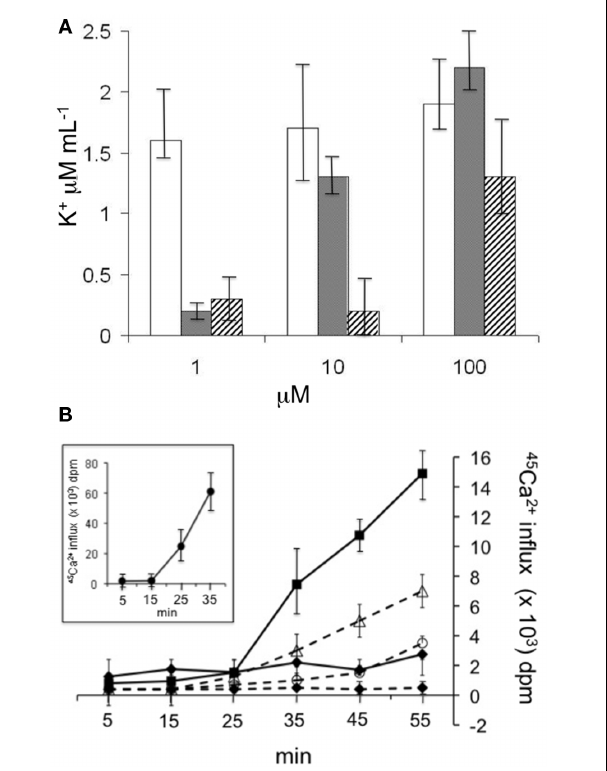
FIGURE 2 | Influence of syringopeptins on ion fluxes of yeast cells. (A) Effects of SRE (blank bars), SP22A (gray bars), and SP25A (striped bars) on K + efflux by yeast S. cerevisiae strain KZ1-1C cells growing inYPD medium. The cells were exposed to designated concentrations of SRE, SP22A, or SP25A and extracellular K + concentrations measured. Control efflux (no treatment) was similar to efflux with SP22A treatment at 1 μ M. Error bars show relative SEs from three separate experiments. (B) Effects on 45 Ca 2 + uptake by S. cerevisiae strain KZ1-1C cell suspensions. SRE, SP22A, and SP25A were added 5min following addition of 45 CaCl 2 . SP22A (solid lines) concentrations were 10 μ M ( (cid:2) ) and 40 μ M ( (cid:3) ); SP25A (dashed lines) concentrations were 10 μ M ( (cid:2) ), 40 μ M ( ◦ ), and 120 μ M ( (cid:5) ).Total CaCl 2 concentration was 50 μ M. SRE concentration was 5 μ M (inset). Error bars indicate SDs of average values from three separate